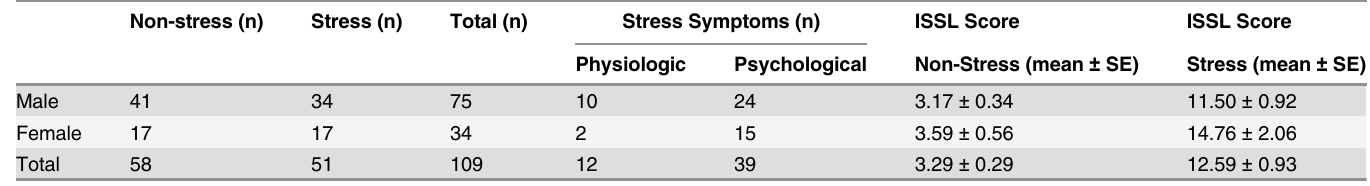
Table 2. Incidence and symptoms of stress in business executives assessed by Lipp Inventory of Stress Symptoms for Adults